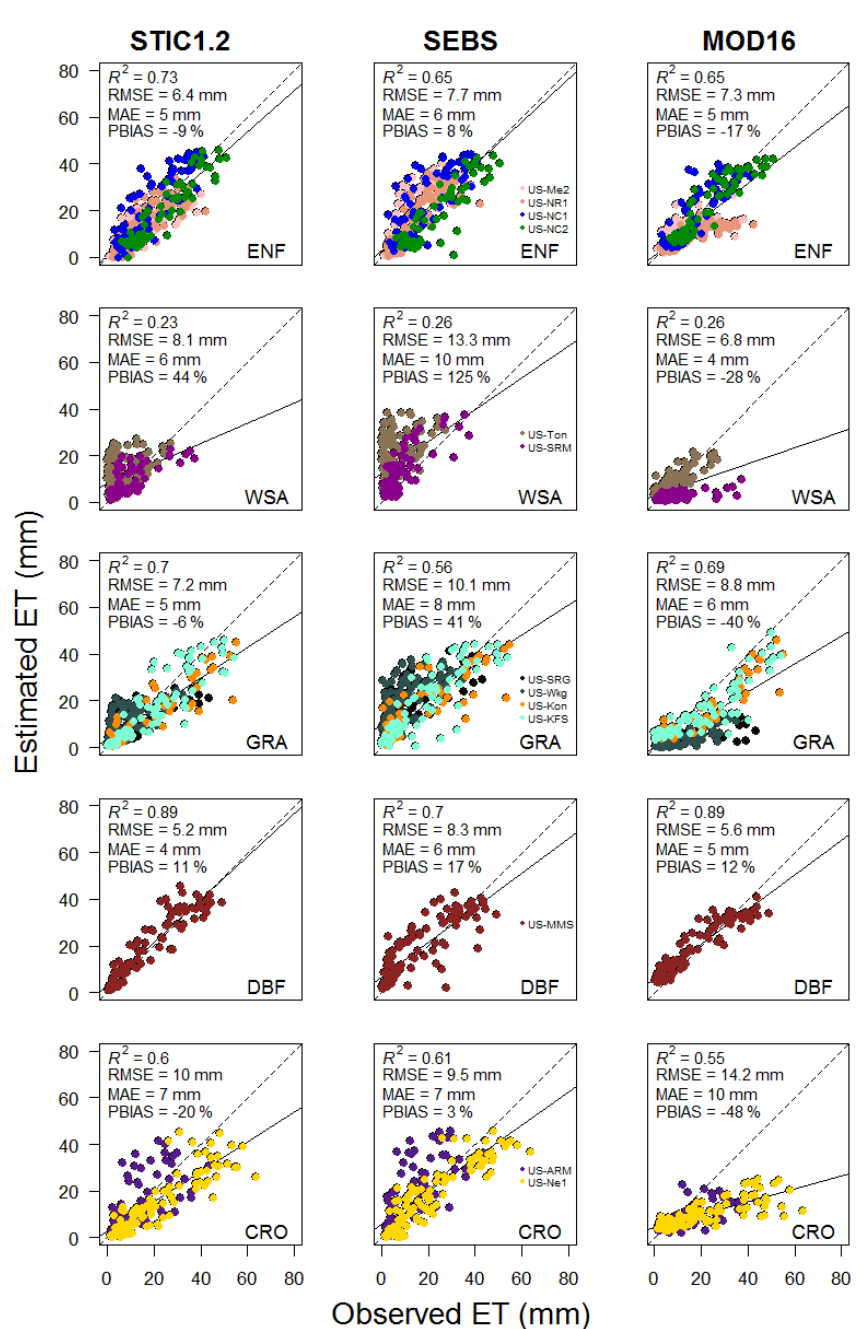
Figure 5. Validation of 8-day cumulative ET from STIC1.2, SEBS, and MOD16 for each biome type.